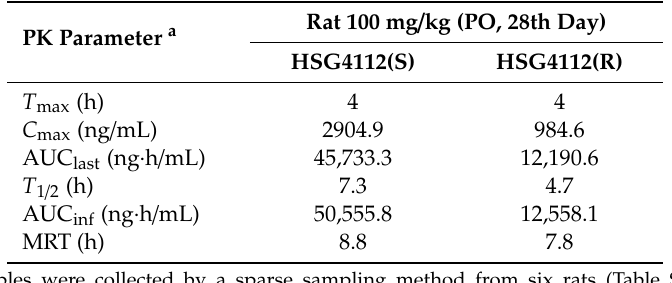
Table 2. Pharmacokinetic parameters of HSG4112(S) and HSG4112(R) after IV administration at a single dose of 10 mg/kg to rats.